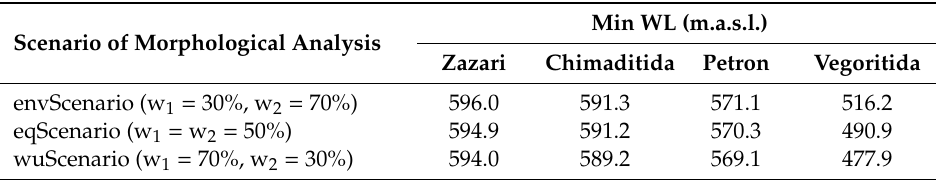
Table 2. Estimated minimum water level (Min WL) for lakes Zazari, Chimaditida, Petron, and Vegoritida according to the morphological analysis